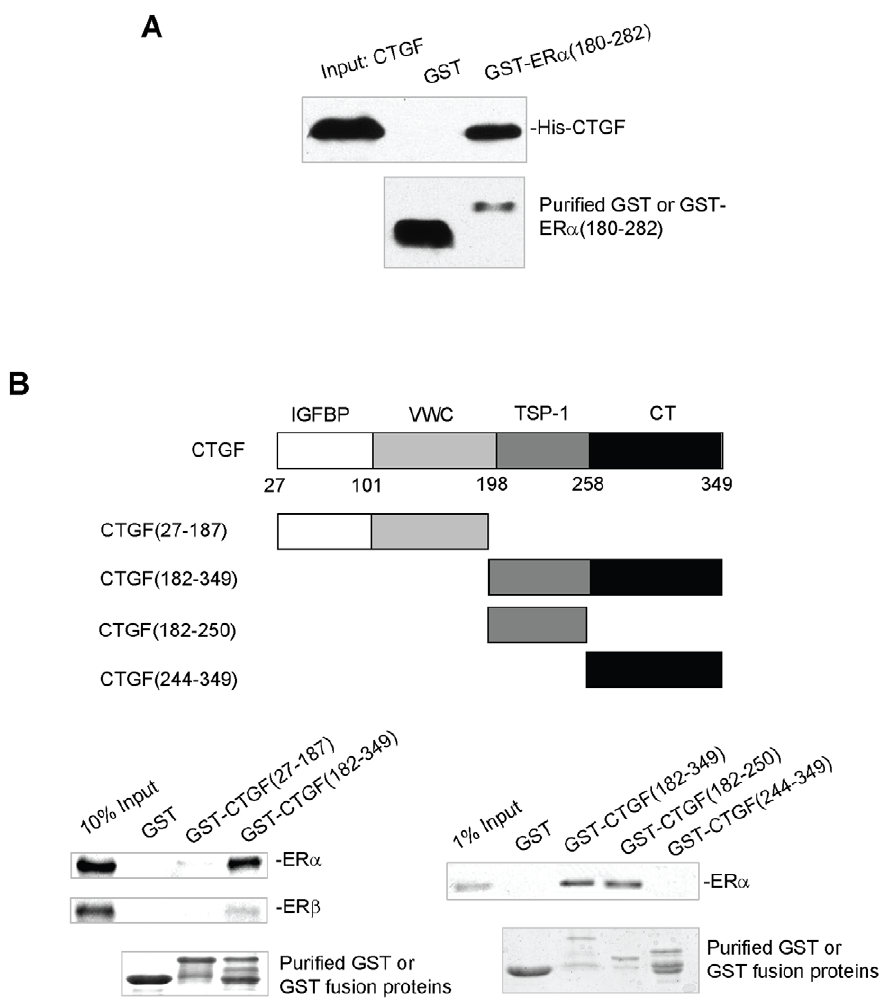
Figure 3. Mapping of the ER a and CTGF interaction domains. (A) Direct interaction of ER a DBD with CTGF. GST or GST-ER a (180–282) was incubated with purified His-CTGF. Bound proteins were analyzed as described in the legend to Figure 2D. (B) Mapping of the ER interaction region in CTGF. 35 S-labelled in vitro translated ER was incubated with GST-CTGF(27–187), GST-CTGF(182–349), GST-CTGF(182–250) or GST-CTGF(244–349), or with GST. The bound proteins were subjected to SDS-PAGE followed by autoradiography. Also shown are schematic diagrams of the constructs used in this study.